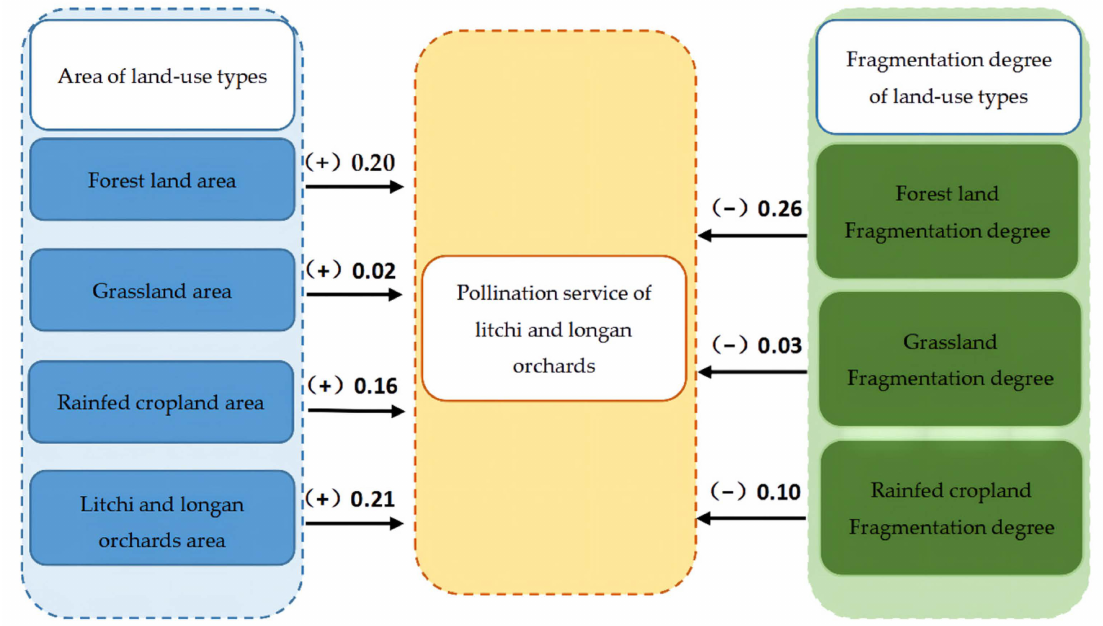
Figure 6. Influence mechanism of land use and its change on the pollination services for litchi and longan orchards. (Note: the influencing factors of the two types shown in the figure are the area of land use type and the landscape fragmentation of land use type. Numbers indicate their respective impact degrees on the pollination services of litchi and longan orchards, ranging from 0 to 1. (+) indicates positive impact, and ( − ) indicates negative